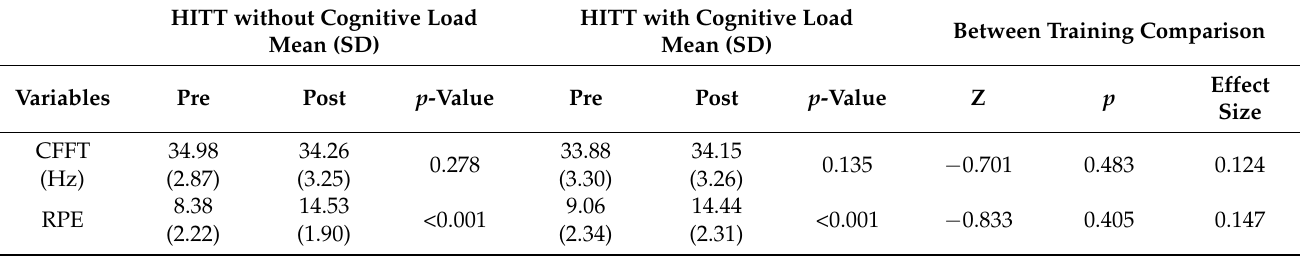
Table 2. Impact of HITT sessions, with and without cognitive load, in the CFFT and